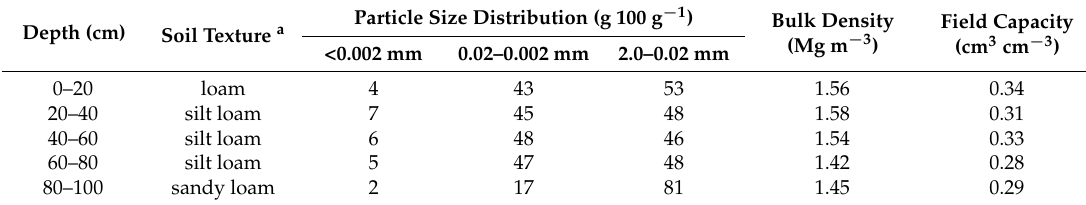
Table 1. Soil physical properties in the experimental field.